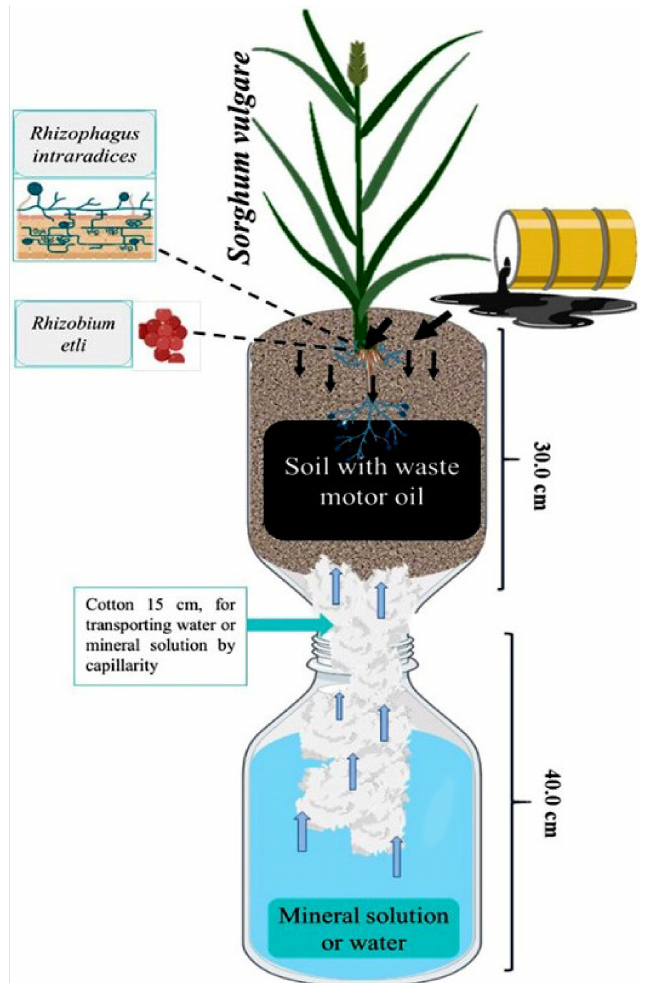
Figure 9. Leonard’s Jar for phytoremediation of agricultural soil polluted by